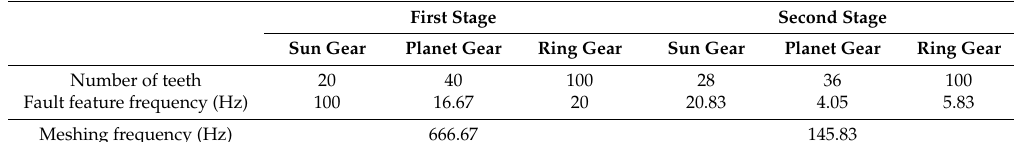
Table 1. Basic parameters of two-stage planetary